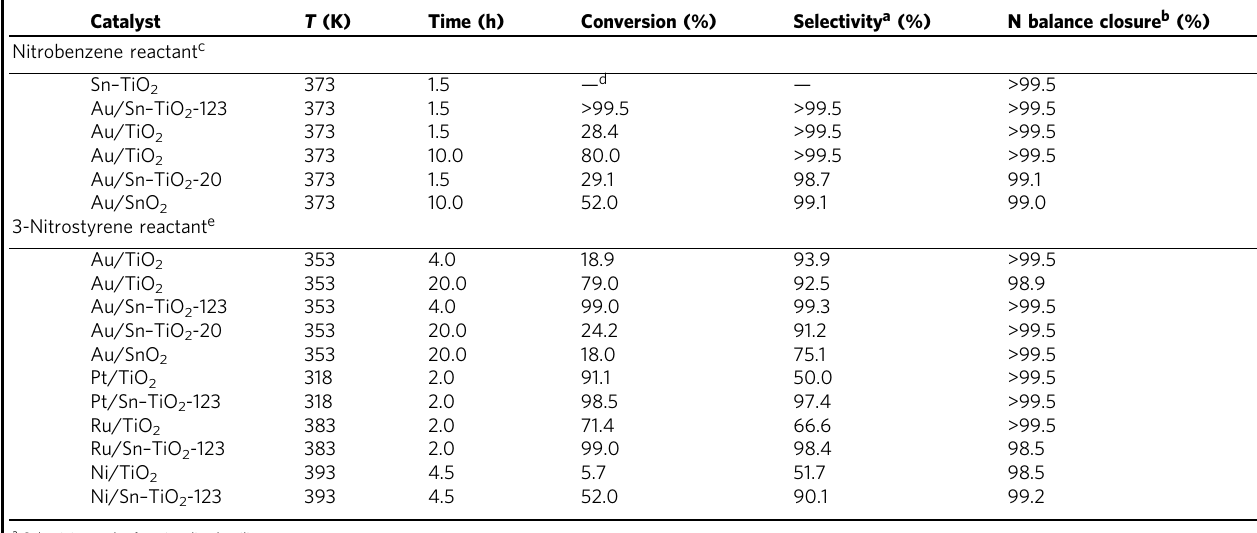
Table 2 Catalytic data characterizing various Au catalysts in the hydrogenation of nitroarenes Catalyst T (K) Time (h) Conversion (%) Selectivity a (%) N balance closure b (%) Nitrobenzene reactant c Sn – TiO